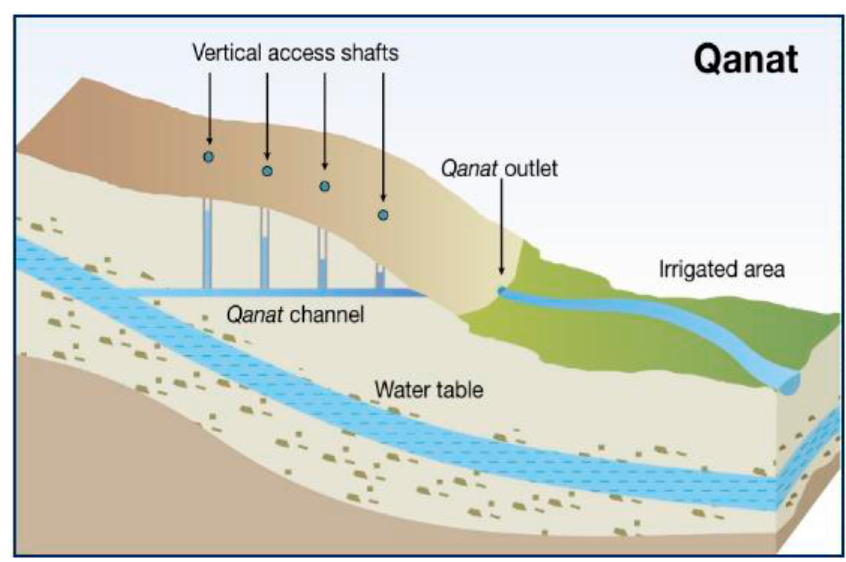
Figure A1. Source: The International Centre on Qanats (ICQHS), Yazd, Iran.